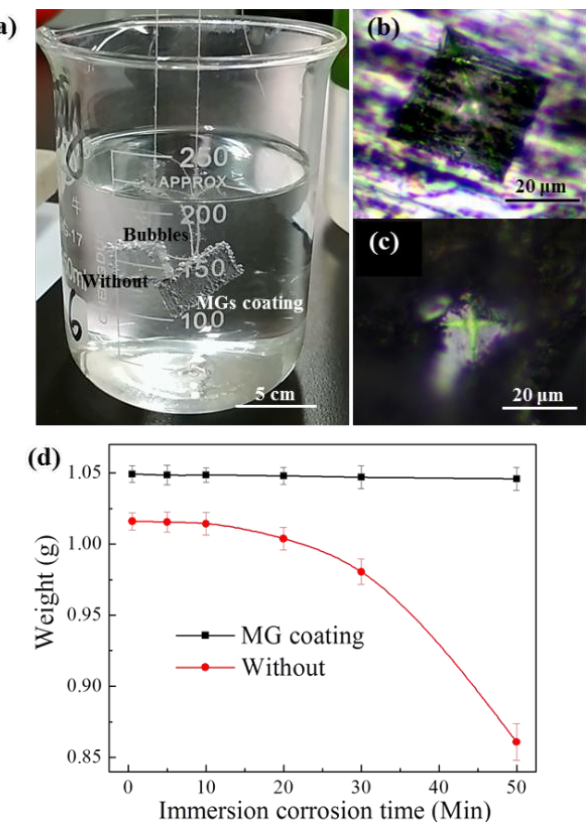
Figure 5. ( a ) Hydrochloric acid (HCl) corrosion of the Al-Cu-Mg-Zn alloy with and without an MG layer; microhardness of the Al-Cu-Mg-Zn alloy without ( b ) and with ( c ) MG layers; ( d ) weightlessness of the Al-Cu-Mg-Zn alloy with and without MG layers in 10 vol % HCl solution.